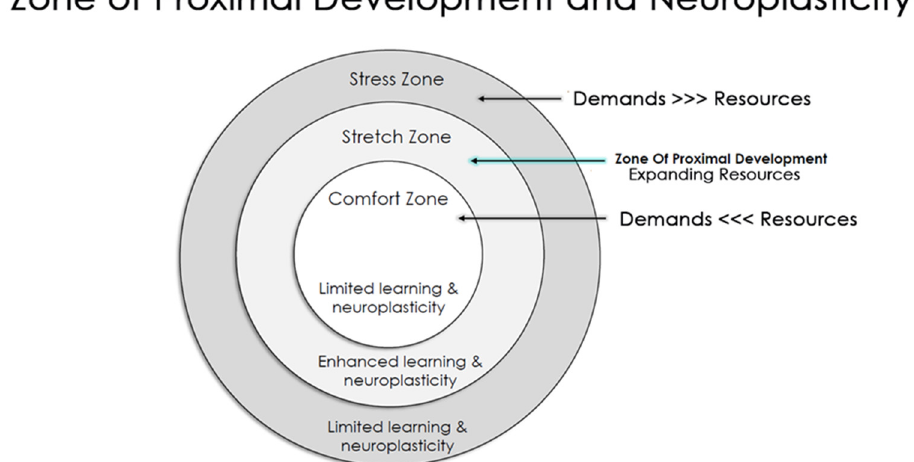
Figure 1. The zone of proximal development and neuroplasticity. An integrative approach between Vygotsky’s educational model and the neuroscience of learning. When learning and performance demands exceed the available support and resources, students are likely to be overwhelmed and resort to survival mode (stress zone). When learning and performance demands are significantly lower than the available support and resources, students are likely to be under stimulated and resort to static mode (comfort zone). When learning and performance demands match the available support and resources, students are likely to be appropriately challenged and work within their zone of proximal development, which promotes neuroplasticity and growth (stretch zone).